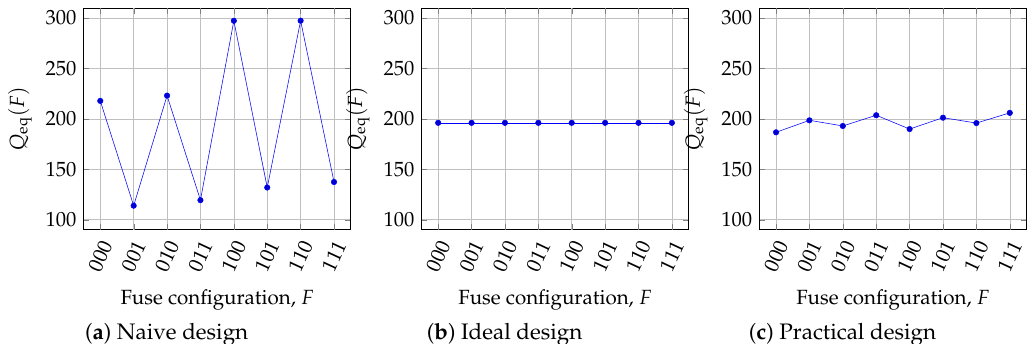
Figure 3. Equivalent Q factor, Q eq ( F ) , of a trimmable capacitor of C = 3pF and ∆ C = 1pF, operating at 433MHz as a function of the configuration of 3 fuses, represented by a binary number, F , where the n th bit represents fuse n , F n . F n = 1 signifies an active fuse, while F n = 0 signifies that fuse n is blown. Plots are shown for three designs: ( a ) The naive design, where all fuses have the same resistance, R f ; ( b ) The ideal design, where all fuses have been scaled to their optimal resistance r f = a f R f ; and ( c ) The practical design, where all the fuses consist of series/parallel combinations of one or two fuses of resistance R f in order to approximate r f, on